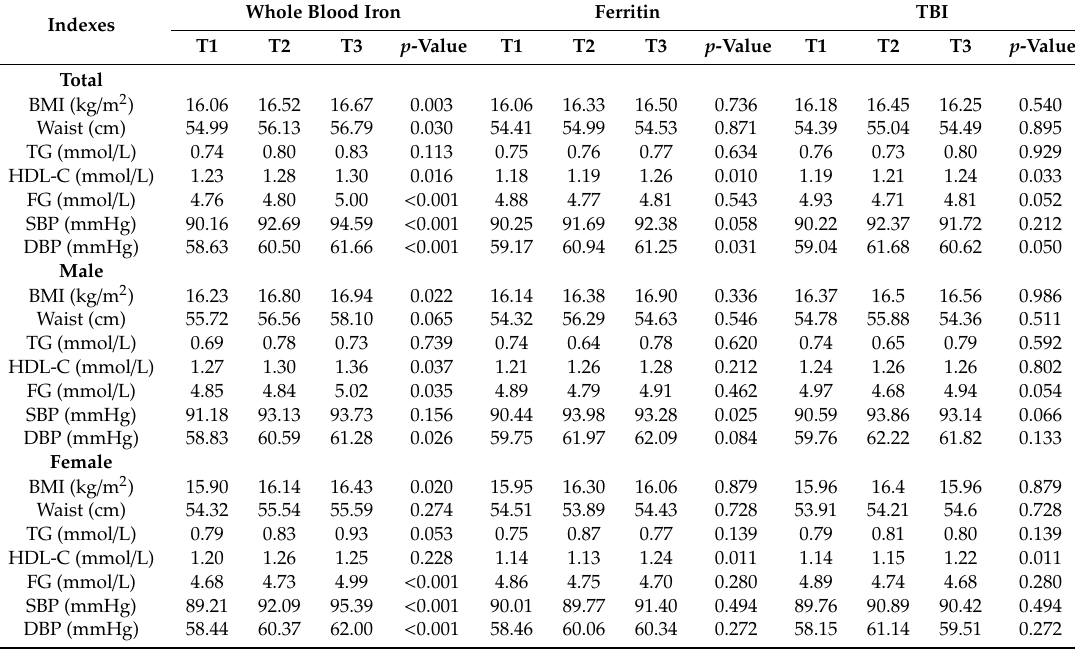
Table 2. Distribution of MetS component indicators by tertiles of iron storage